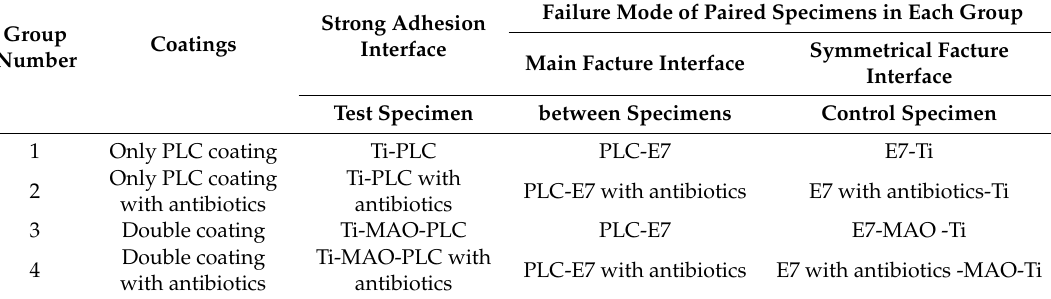
Figure 5. Images of fractured surface for ( A , B ) PLC coating (group 1), ( C , D ) PLC coating with antibiotics (group 2), ( E , F ) double coating (group 3), ( G , H ) double coating with antibiotics (group 4). Table 2. The details of which interface failed for each group during tensile testing.